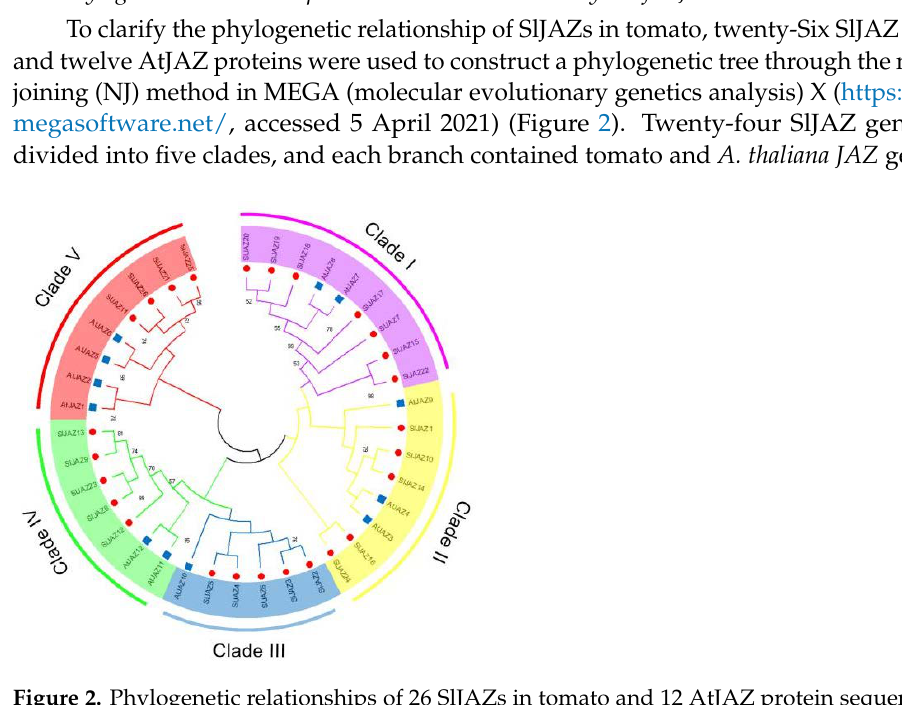
Figure 3. Gene structure of JAZ gene family members in tomato. ( A ) Phylogenetic tree of the JAZ gene family in tomato. Branches of the same color represent the same subgroup. ( B ) Distribution of introns and exons. ( C ) Distribution of motifs. Asterisks indicate the motifs shared by SlJAZ genes.